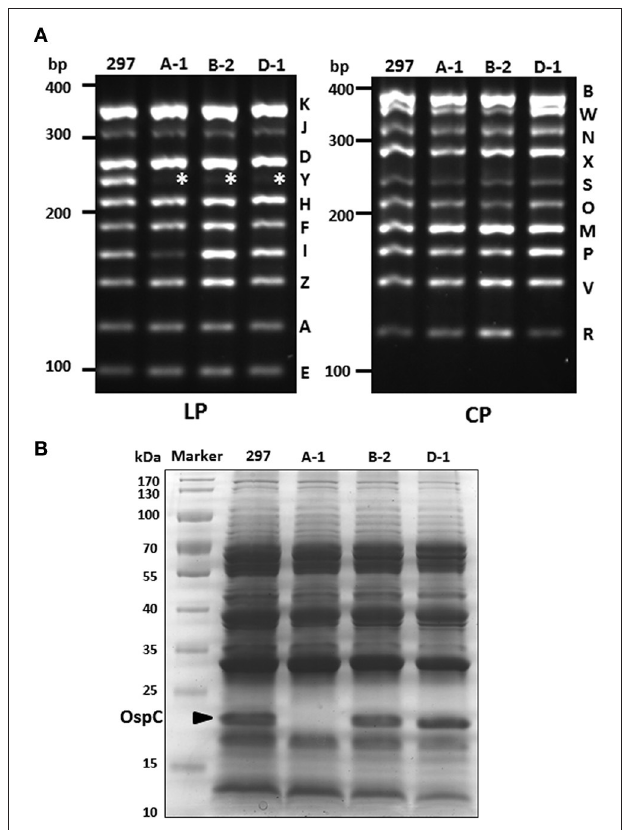
FIGURE 3 | Plasmid profiles of additional clones with high or low OspC levels. (A) Plasmid profile. Clones A-1, B-2, D-1 lost lp28-5 (indicated by asterisk). LP, linear plasmid; CP, circular plasmid. (B) SDS-PAGE. Spirochetes were cultivated at 37 ◦ C and harvested at stationary phase of growth. The band corresponding to OspC is indicated by arrow.